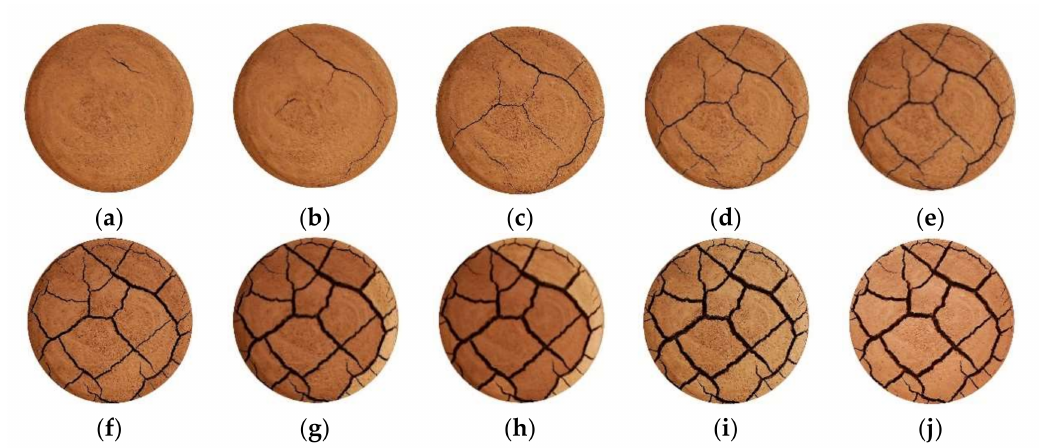
Figure 7. Crack development diagram of red clay at different times. ( a ) 76 h, ( b ) 80 h, ( c ) 84 h, ( d ) 86 h, ( e ) 88 h, ( f ) 96